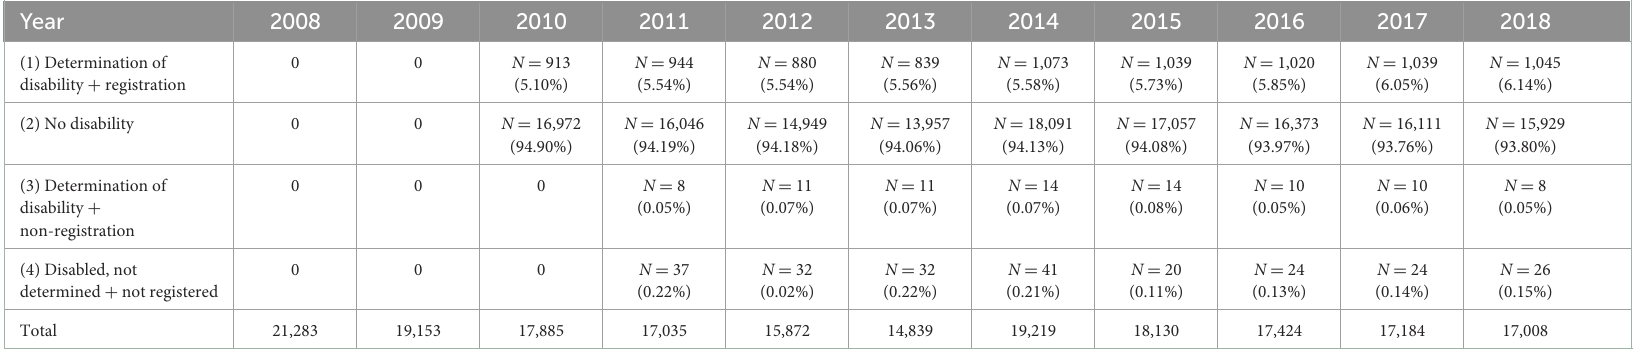
TABLE 1 Korea health panel registration of persons with disabilities